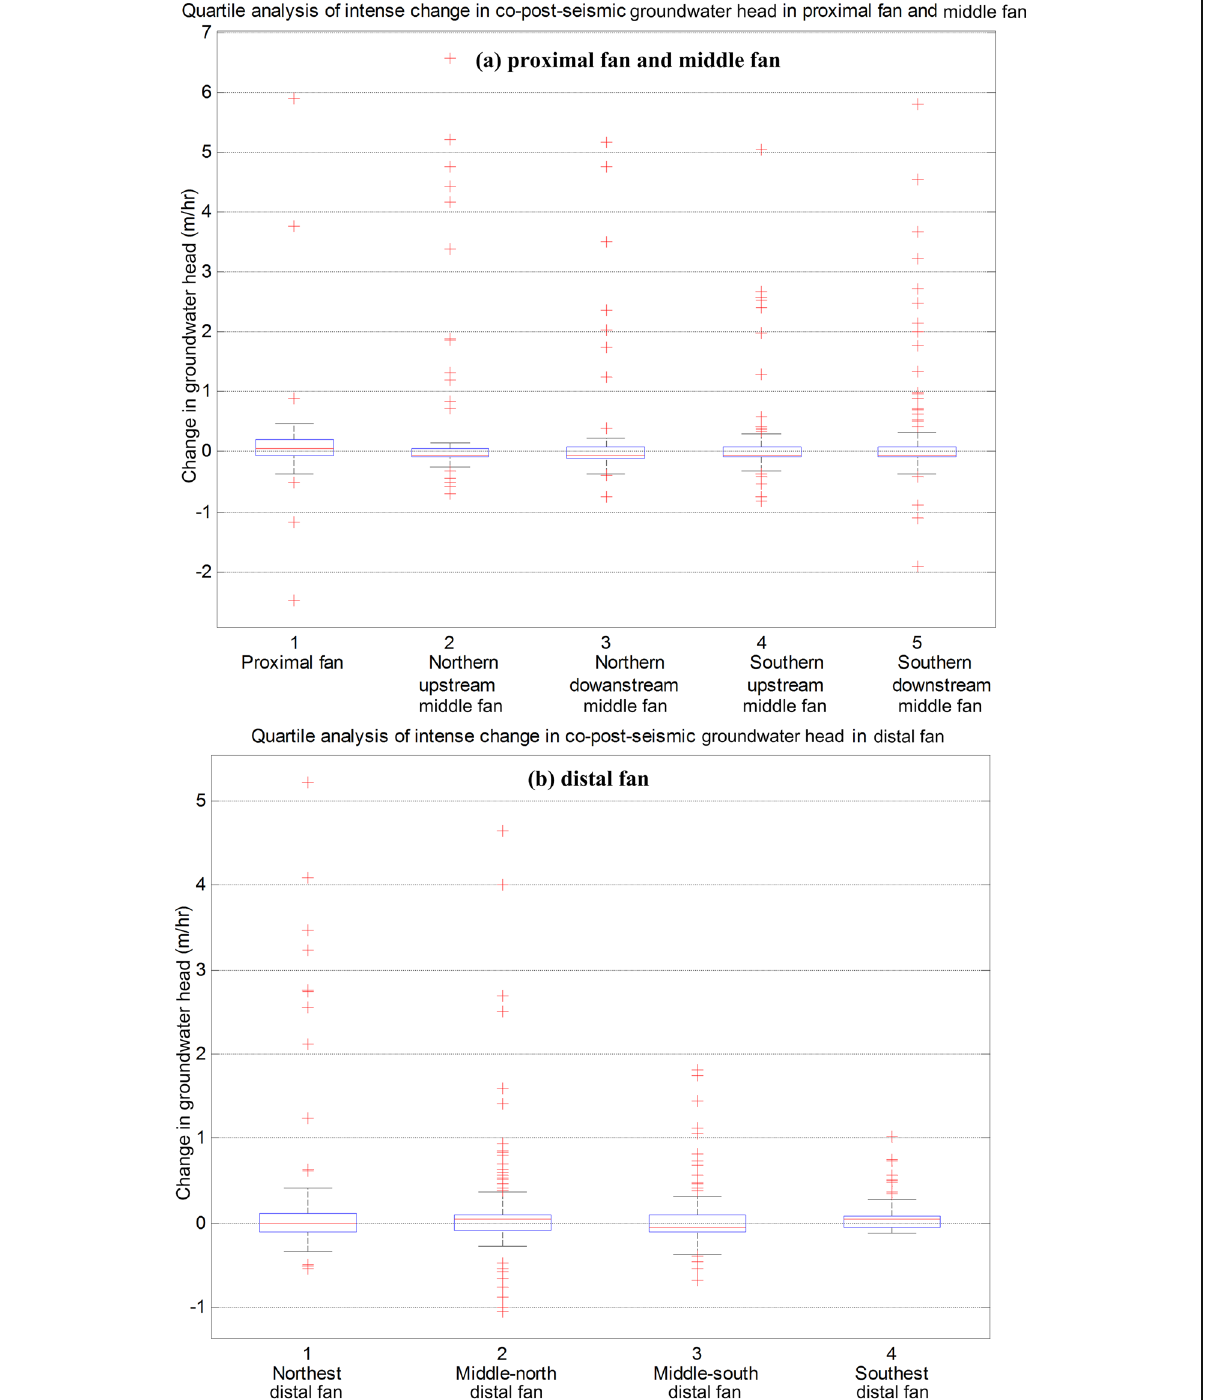
Fig. 7 Quartile patterns of change in co-post-seismic groundwater head ( Δ t = 1 h) across multiple sub-fans in a proximal and middle fans and b distal